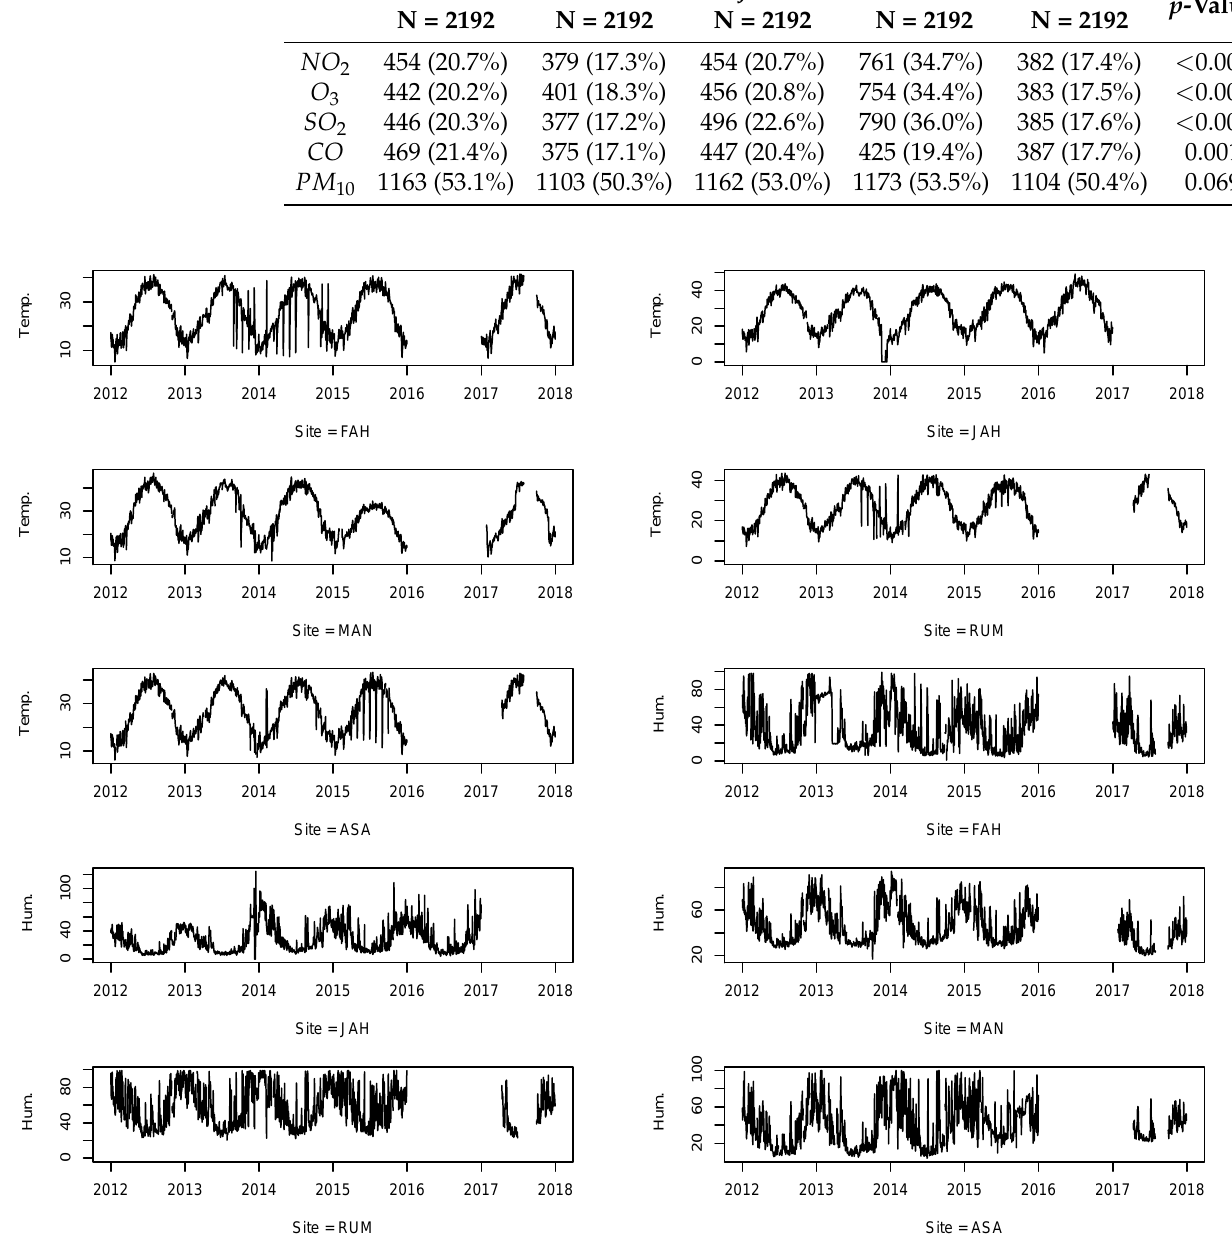
Figure 4. Time-series of weather climatology (temperature and relative humidity) from 2012 to 2017, with missing values from five different locations (stations) in the State of